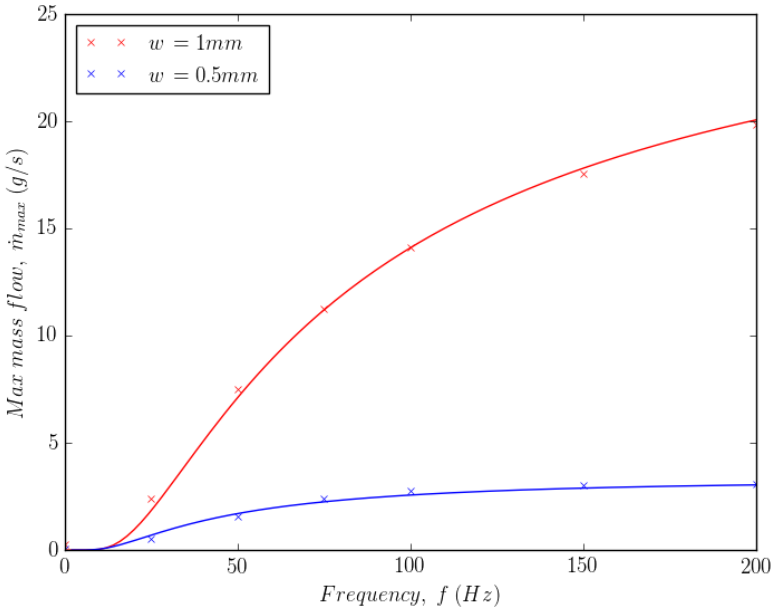
Figure 13. Maximum mass flow versus frequency at low